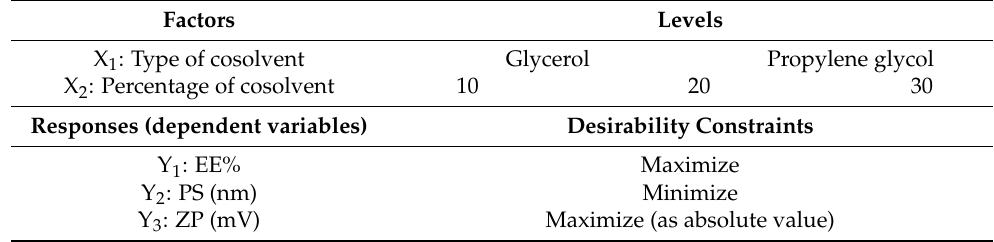
Table 2. Full (3 1 .2 1 ) factorial design for optimization of TOL-cosolvent spanlastics. Factors